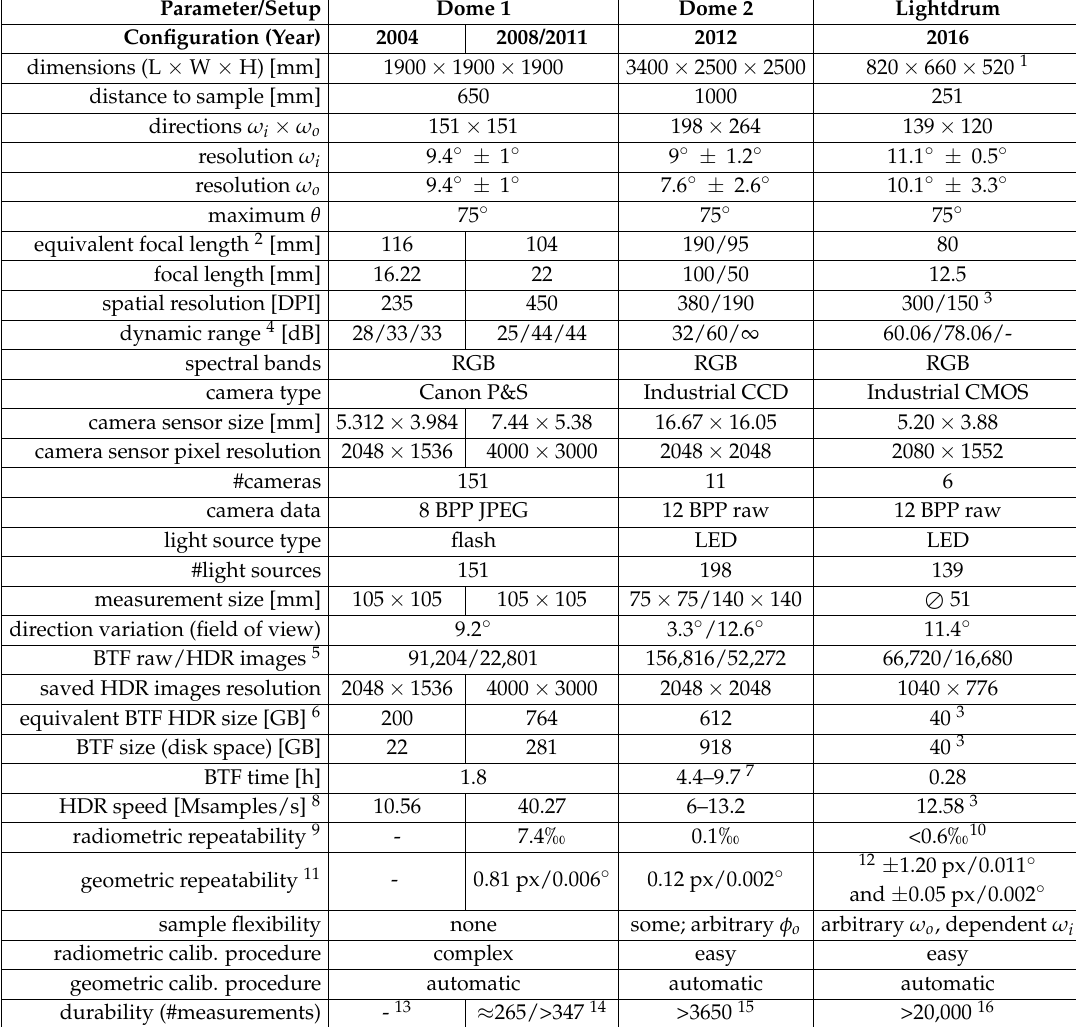
Table 1. Comparison of the two stationary dome based setups made by the University of Bonn and our proposed portable setup lightdrum. The table was adopted from [4], restricted only to BTF measurements and extended by several